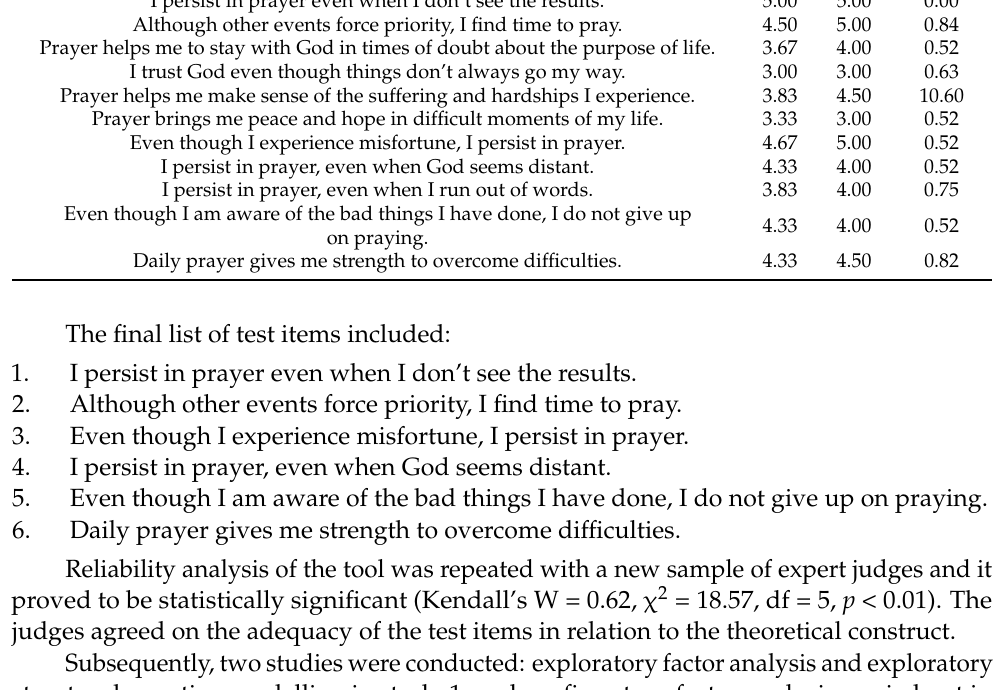
Table 1. Expert judges’ rating of test items: Means, Medians, and Standard Deviations. Items